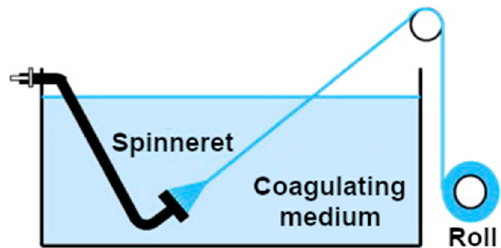
Figure 4. The spinning of CNT fibers modified and reproduced with permission from [114], Copy- right Elsevier (2014).